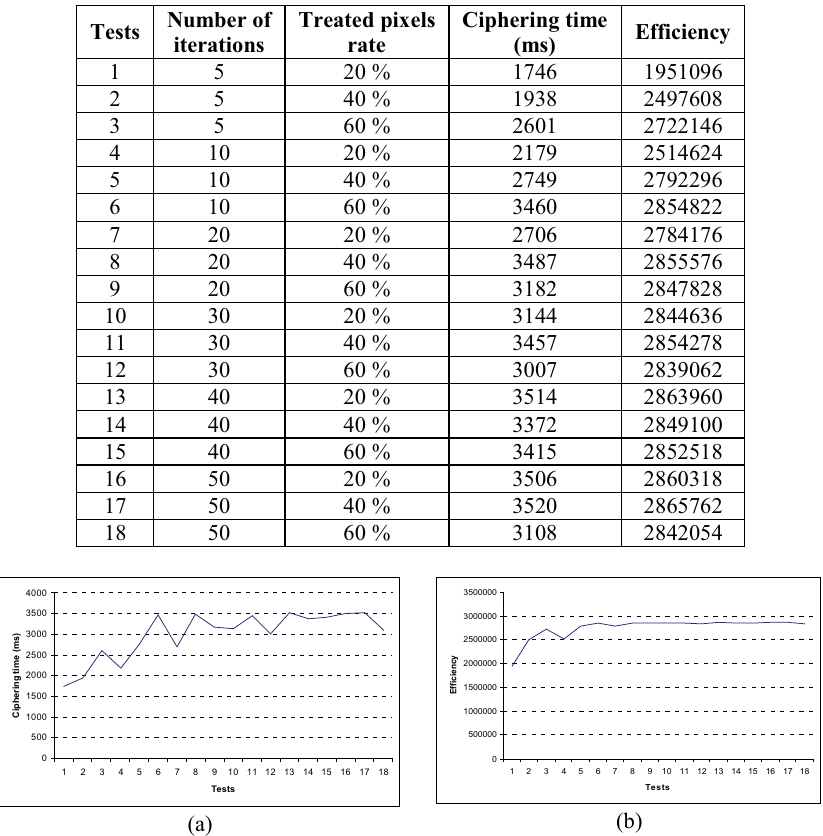
Table 5. Evolution of S2CA-EX efficiency and ciphering time according to the number of iterations and the processed pixels rate.